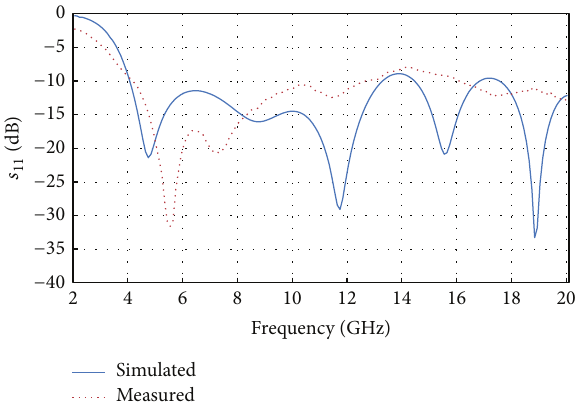
Figure 4: Comparison of gain for w/out triangular patches.